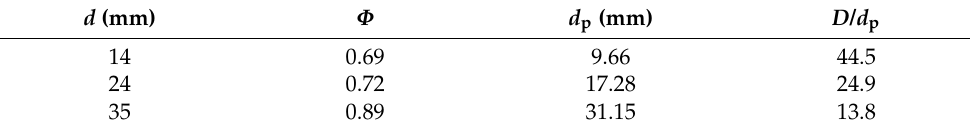
Table 1. Related parameters of sinter particles.